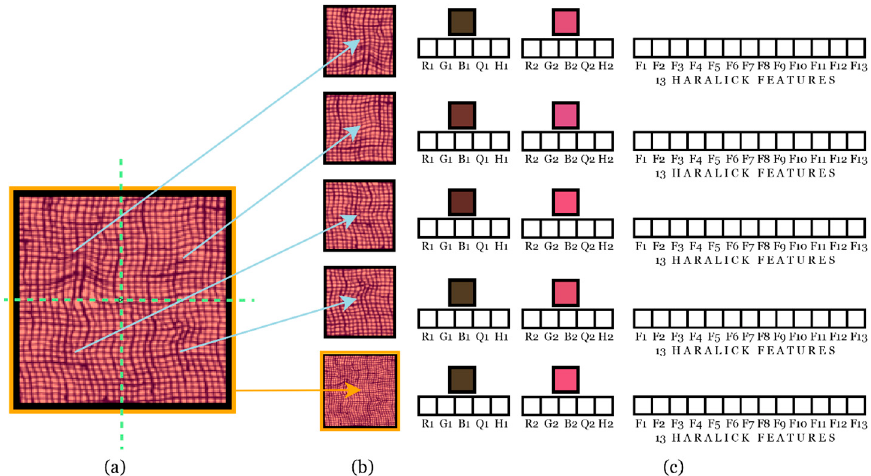
Figure 7. Feature vector extracted from one image from the Brodatz Database. ( a ) The original image is divided into five partitions ( b ): four local partitions and one global (the same image, bottom). ( c ) The feature vectors obtained from each partition. The color feature vector and texture feature vector are concatenated.